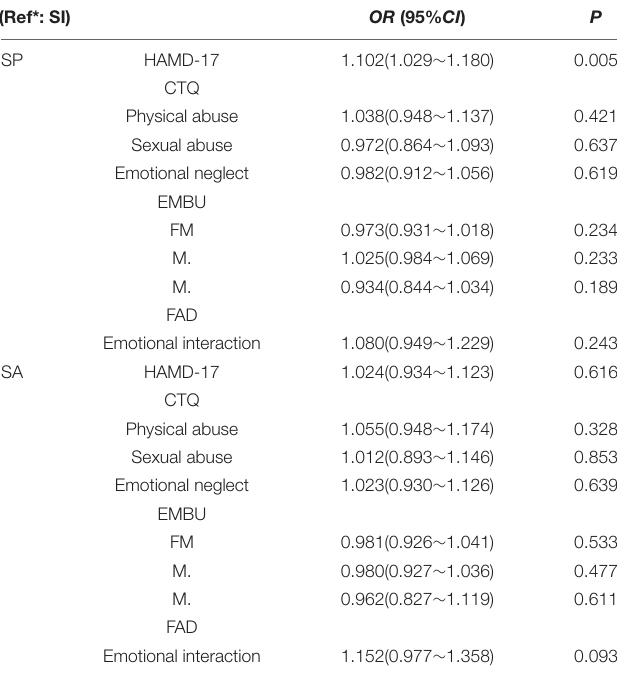
TABLE 3 | Multiple logistic regression analysis among SI, SP and